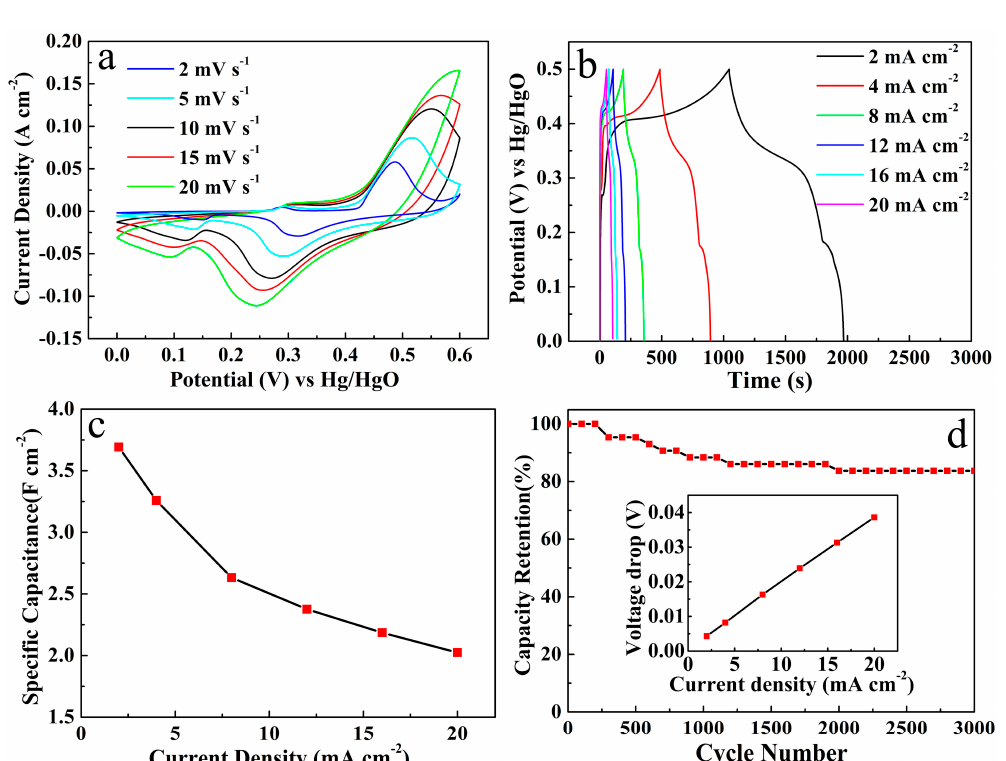
Figure 5. Electrochemical performance of the Ag / Ni(OH) 2 composite electrode: ( a ) The CV curves, ( b ) GCD curves, ( c ) plots of specific capacitance versus current density, ( d ) cycling performance, inset is voltage drops during the GCD tests of the Ag / Ni(OH) 2 composite electrode.